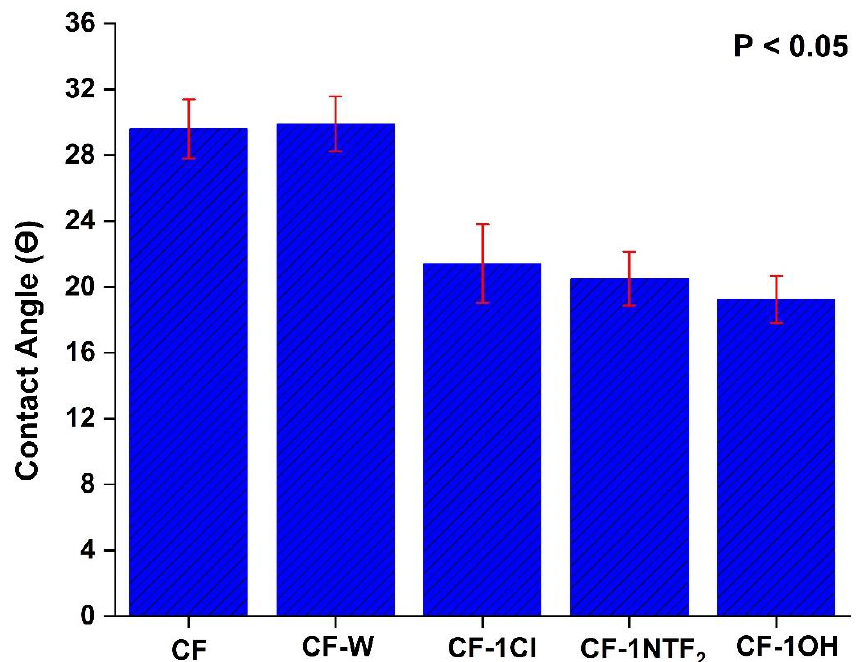
Figure 3 . Contact angles of epoxy resin: CF, CF-1Cl, CF-1NTf 2 and CF-1OH. Figure 3. Contact angles of epoxy resin: CF, CF-1Cl, CF-1NTf